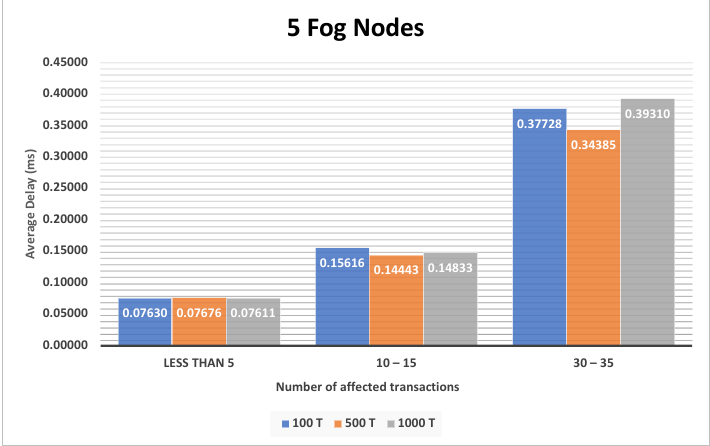
Figure 9. The impact of different number of transactions on five fog